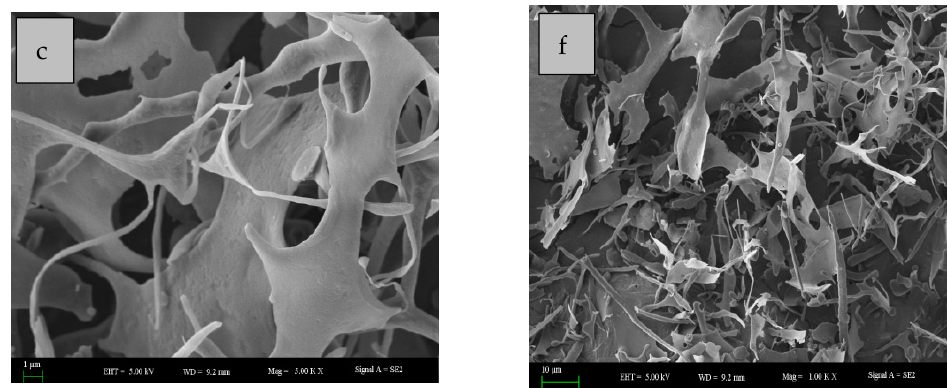
Figure 5. Scanning electron microscopy picture EAP-H-a2 ( a – c ); EAP-H-a1 ( d – f ).